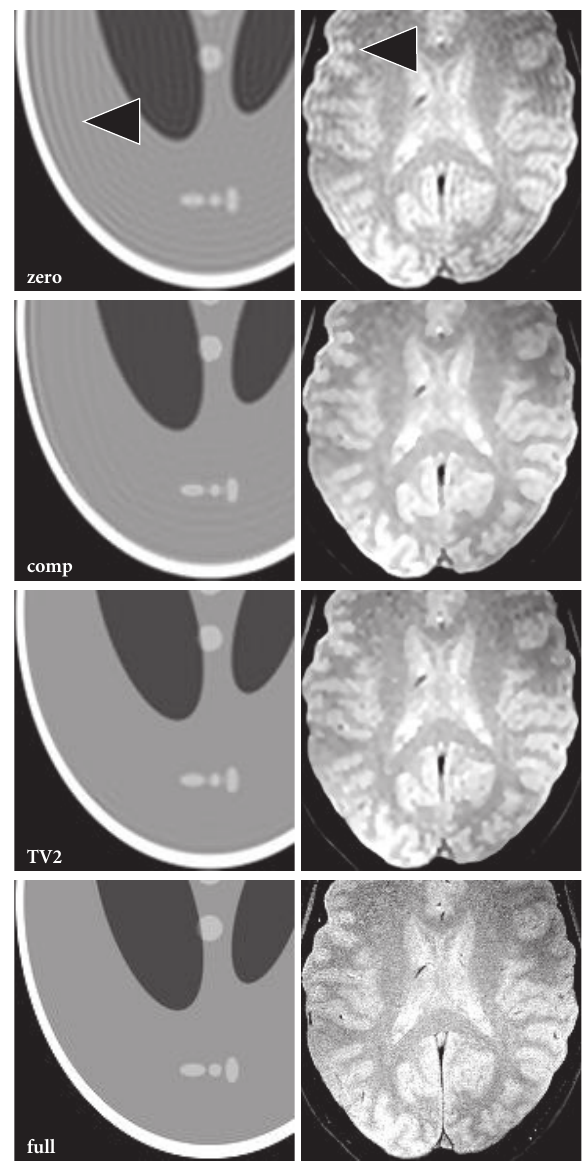
Figure 4: (Left) Images of the Shepp-Logan phantom (96 × 96 samples, 288 × 288 reconstruction matrix) and (right) gradient- echo images of the human brain in vivo (TR/TE = 500/8ms, BW 80 Hz/pixel, FA 30 ◦ , 2mm slice) reconstructed using zero-padding (zero), the extrapolation method by Constable and Henkelman (comp), and the proposed method with first- and second-order derivatives (TV2). For comparison, reconstructions from fully sampled 288 × 288 matrices are shown (full). Arrows = truncation